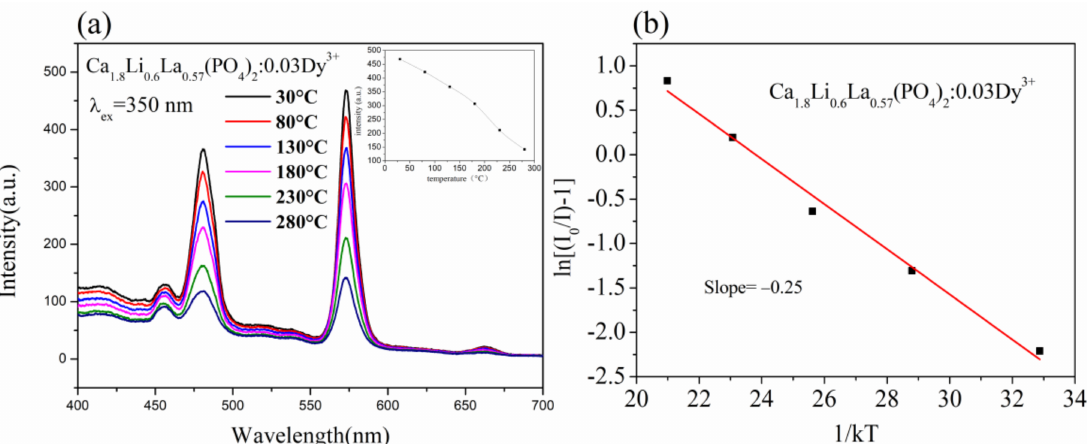
Figure 7. ( a ) The temperature-dependent photoluminescence emission spectra of Ca 1.8 Li 0.6 La 0.57 (PO 4 ) 2 :0.03Dy 3+ phosphor( λ ex = 350 nm) and ( b ) the relationship between ln [( I 0 / I ) − 1] and 1/ kT of Ca 1.8 Li 0.6 La 0.57 (PO 4 ) 2 :0.03Dy 3+ phosphor.